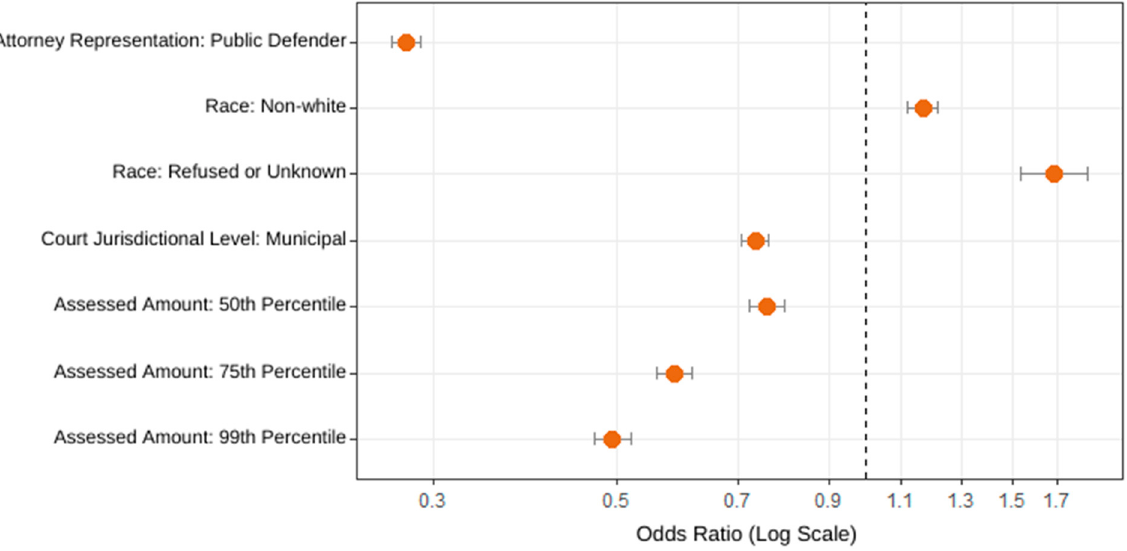
Figure 4. Odds ratios for the various predictors of full LFO payment within 180 days of assessment.